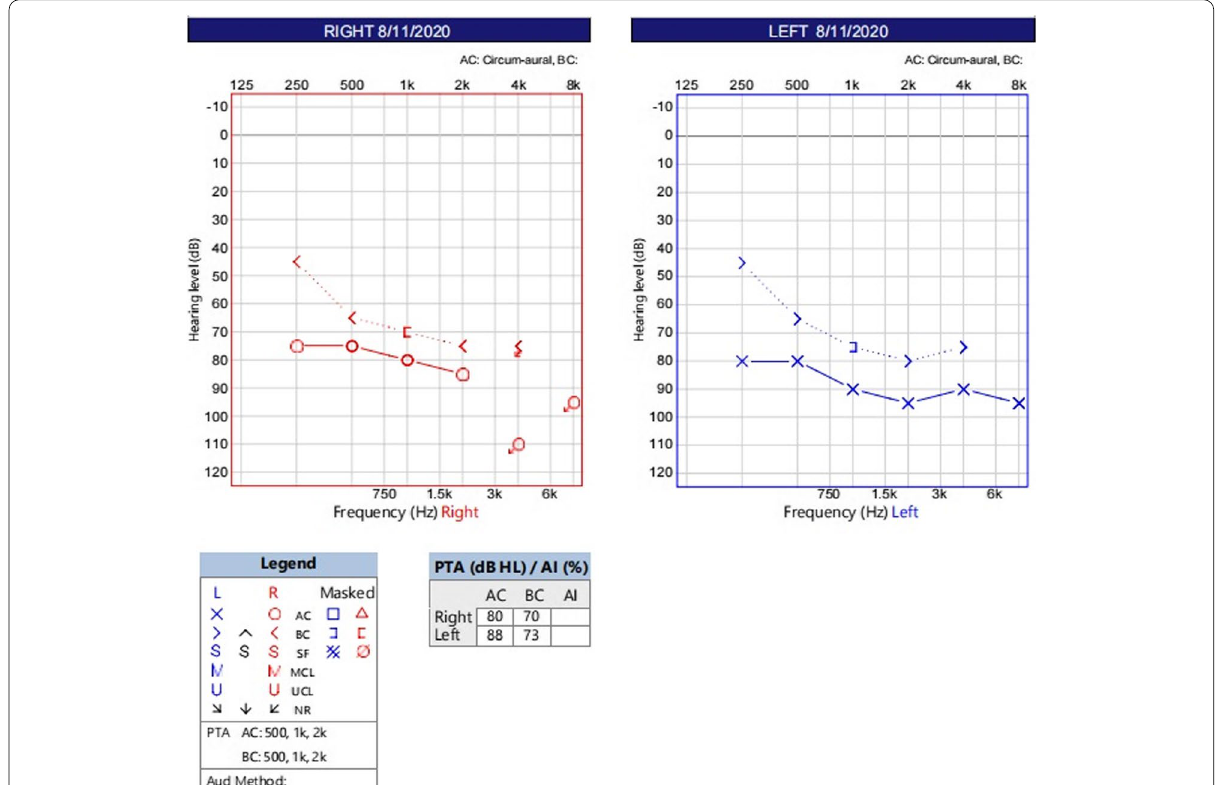
Fig. 2 Audiogram 1 year after the audiogram in Fig. 1, hearing loss progressed into bilateral severe to profound sensorineural hearing